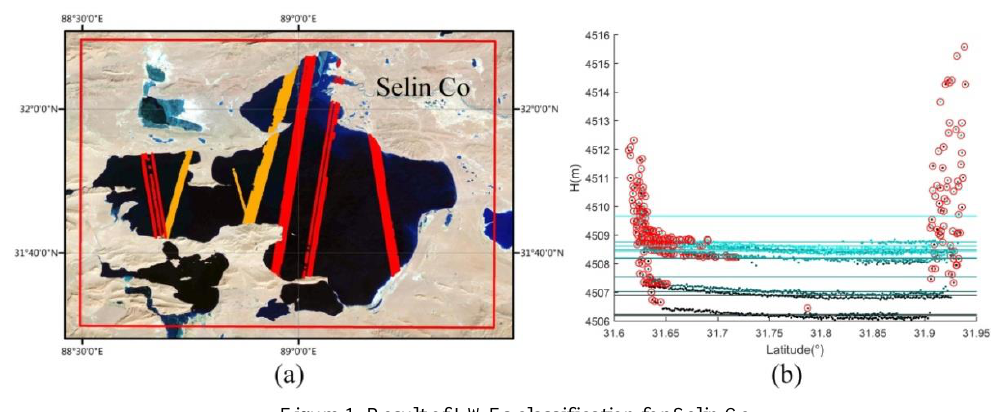
Figure 1. Result of LWFs classification for Selin Co